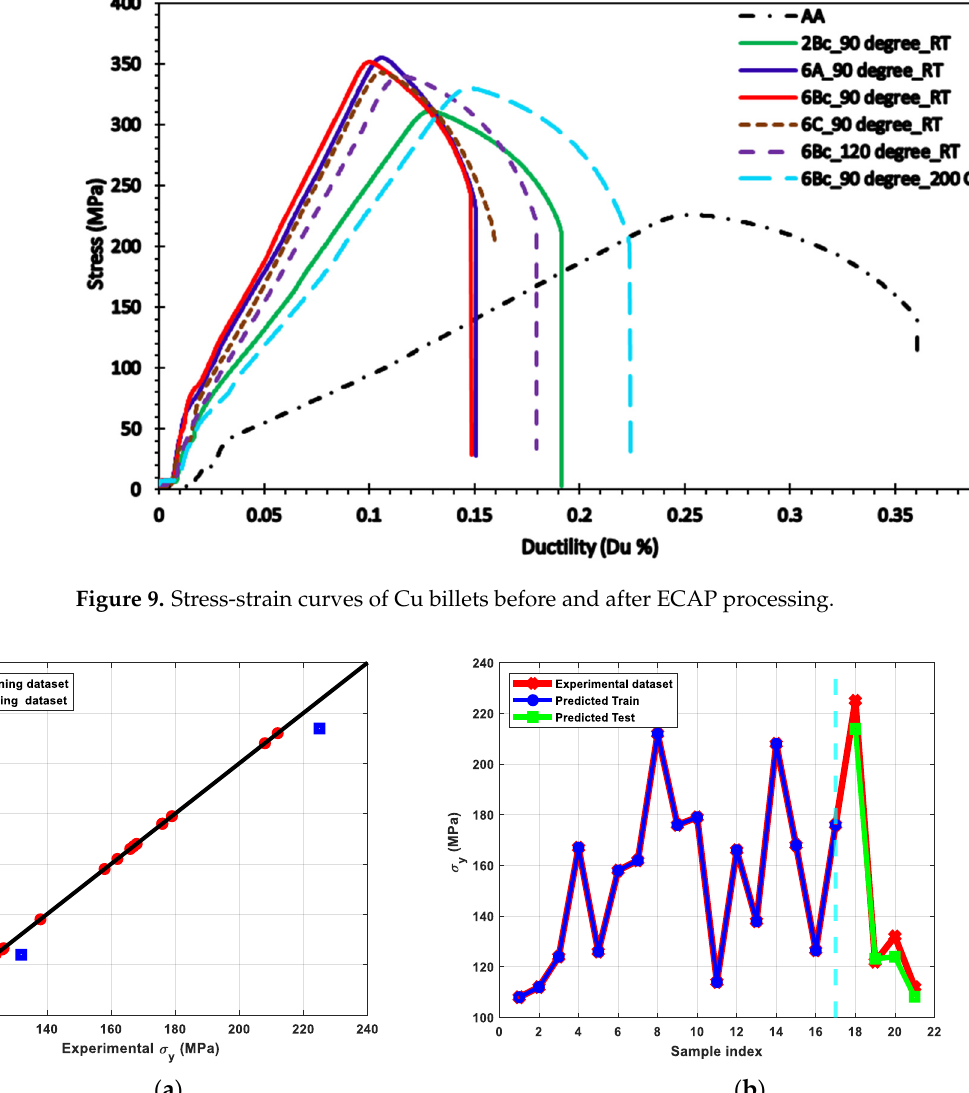
( b ) Figure 11. ( a ) Predicted versus experimental σ u evaluated for the training and the testing sets, ( b ) Predicted σ y versus sample index plotted for predicted train, predicted test, and experimental σ u data. ( a )